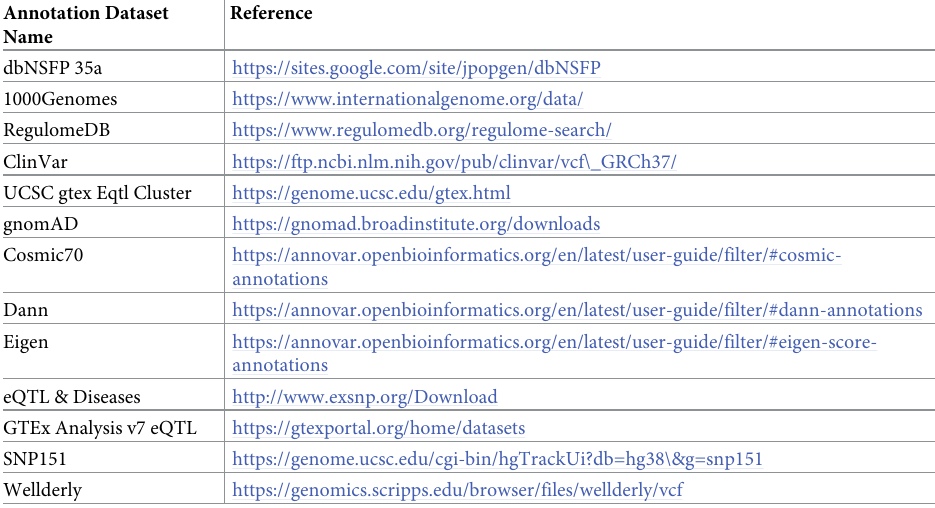
Table 2. Databases used for annotating the 1000 Genomes data sets in this